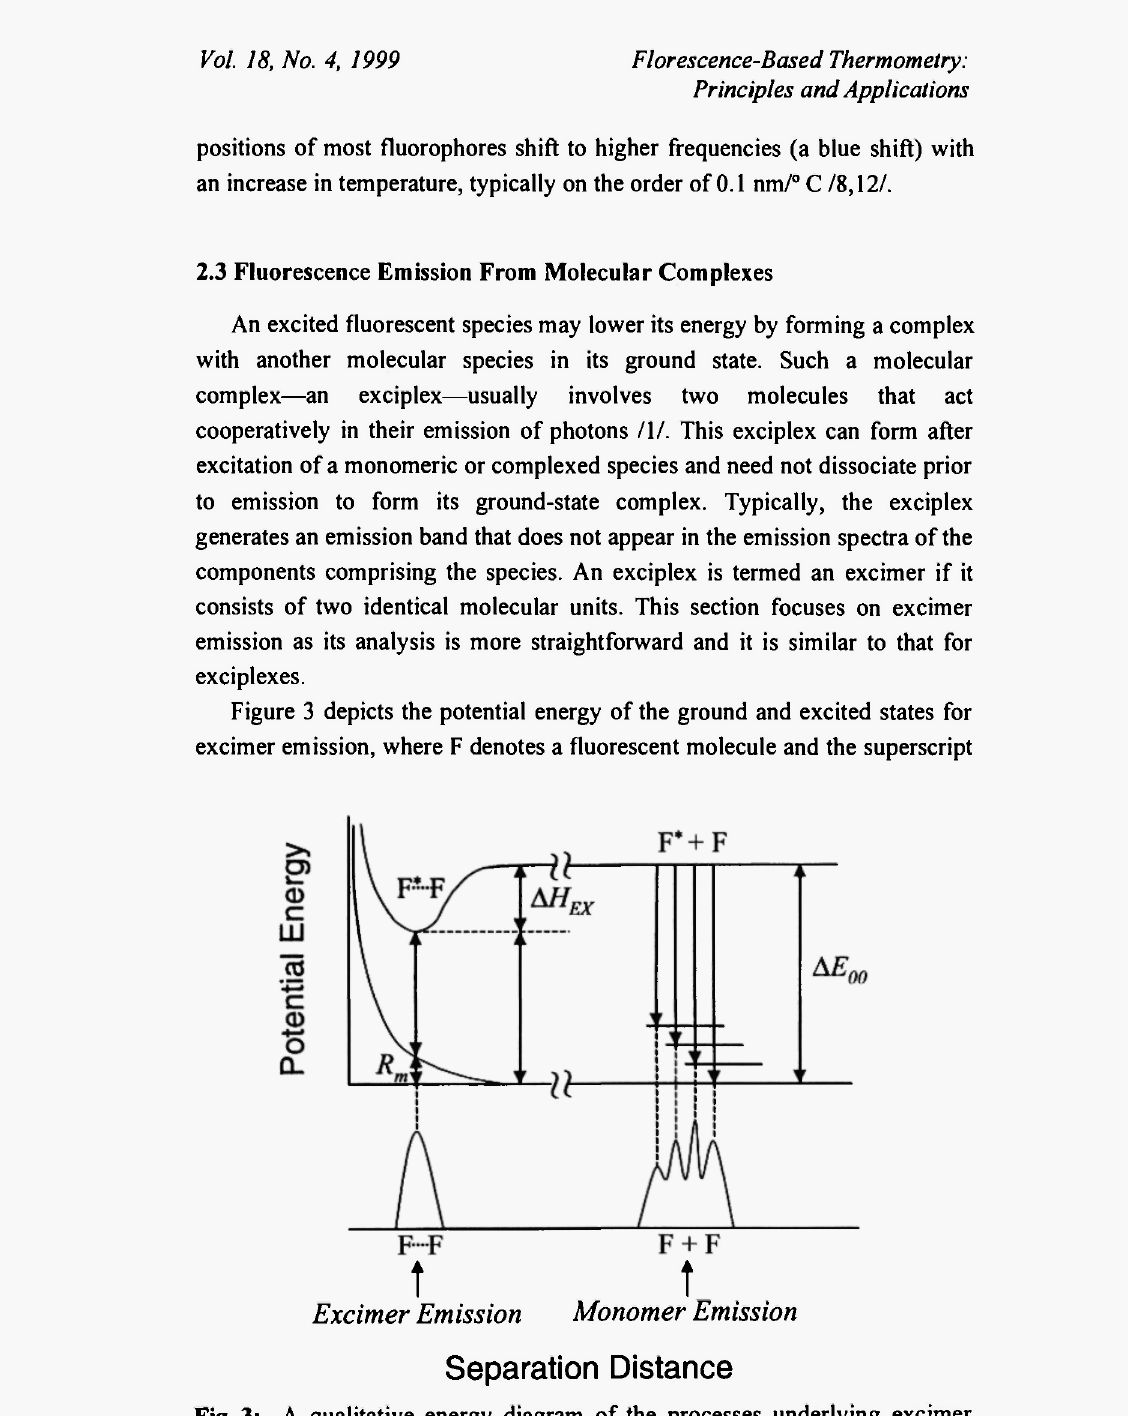
Fig. 3: A qualitative energy diagram of the processes underlying excimer and monomer